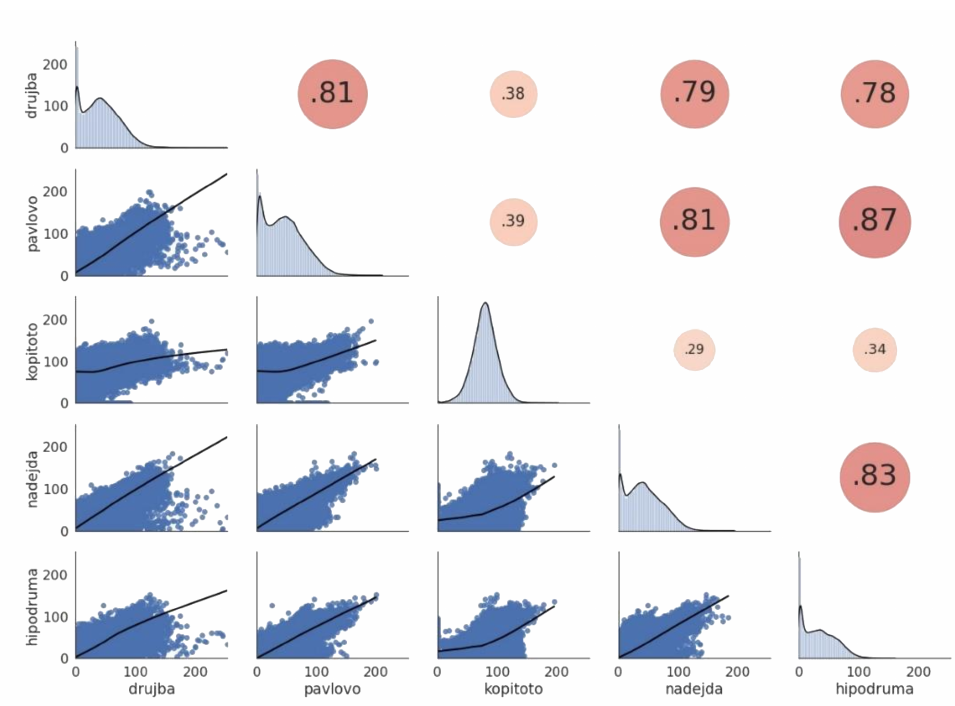
Figure 3. Interaction relationships—scatterplot (lower left triangular area) and Pearson correlation values (upper right triangular area) and histogram (on the diagonal) of the O 3 at each air quality station measured per hour.